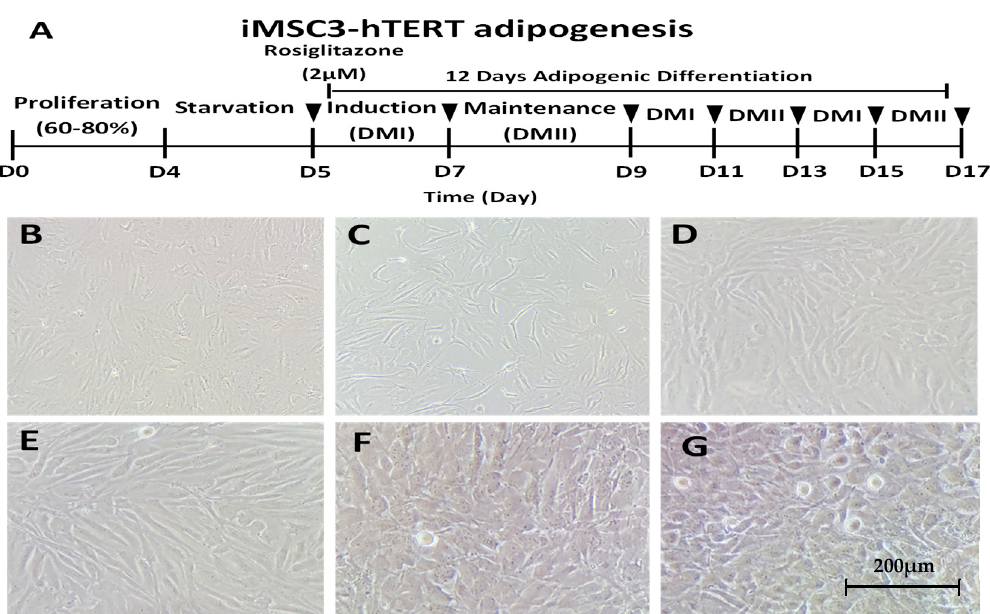
Figure 1. Differentiation of telomerase-transformed mesenchymal stromal cells into adipocytes: ( A ) adipogenic differentiation protocol of iMSC3-hTERT for three cycles (in total, 12 days) with and without rosiglitazone; ( B ) 50–60% confluent mesenchymal stromal cells; ( C ) cells after 24 h of serum starvation; differentiating adipocytes at the initial stages of induction ( D ) without and ( E ) with rosiglitazone; and mature adipocytes after 12 days of differentiation in control cells ( F ) and cells with rosiglitazone treatment ( G ).